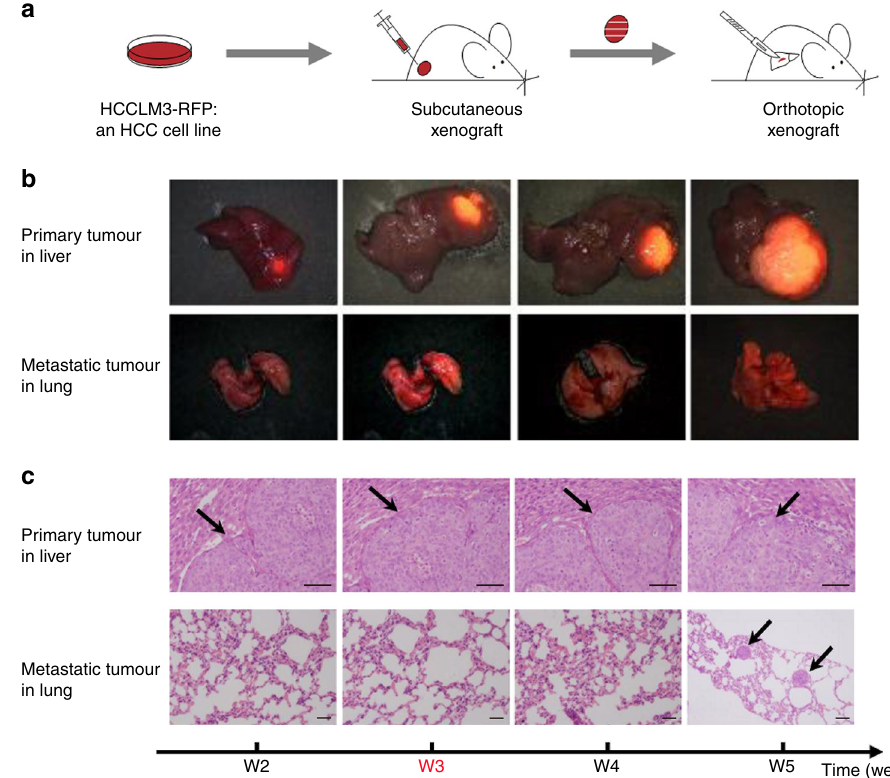
Fig. 1 Xenograft mouse model of HCCLM3-RFP for pulmonary metastasis of hepatocellular carcinoma (HCC). a The fl owchart showed the process of creating the xenograft mouse model, HCCLM3-RFP. Stage I, HCCLM3-RFP cell lines were cultured and ampli fi ed. Stage II, each of three nude mice were injected subcutaneously with 1 × 10 7 /0.2 ml HCCLM3-RFP cells in the right upper fl ank region to establish the subcutaneous xenograft model. Stage III, after 30 days the subcutaneous tumour was removed and cut into pieces and implanted orthotopically into the livers of other mice. b The series of images showed the growth and metastasis of transplanted hepatic tumours in each of the orthotopic xenograft mice from the second week after orthotopic implantation to the fi fth week. The transplanted tumours in the mice livers increased gradually from the second week, and spontaneous pulmonary metastasis of HCCLM3-RFP could be observed only at the fi fth week. c Histological images of tissue sections stained with haematoxylin and eosin (H&E) at each time point validated the progression of hepatocarcinogenesis and pulmonary metastasis (scale bar, 100 μ